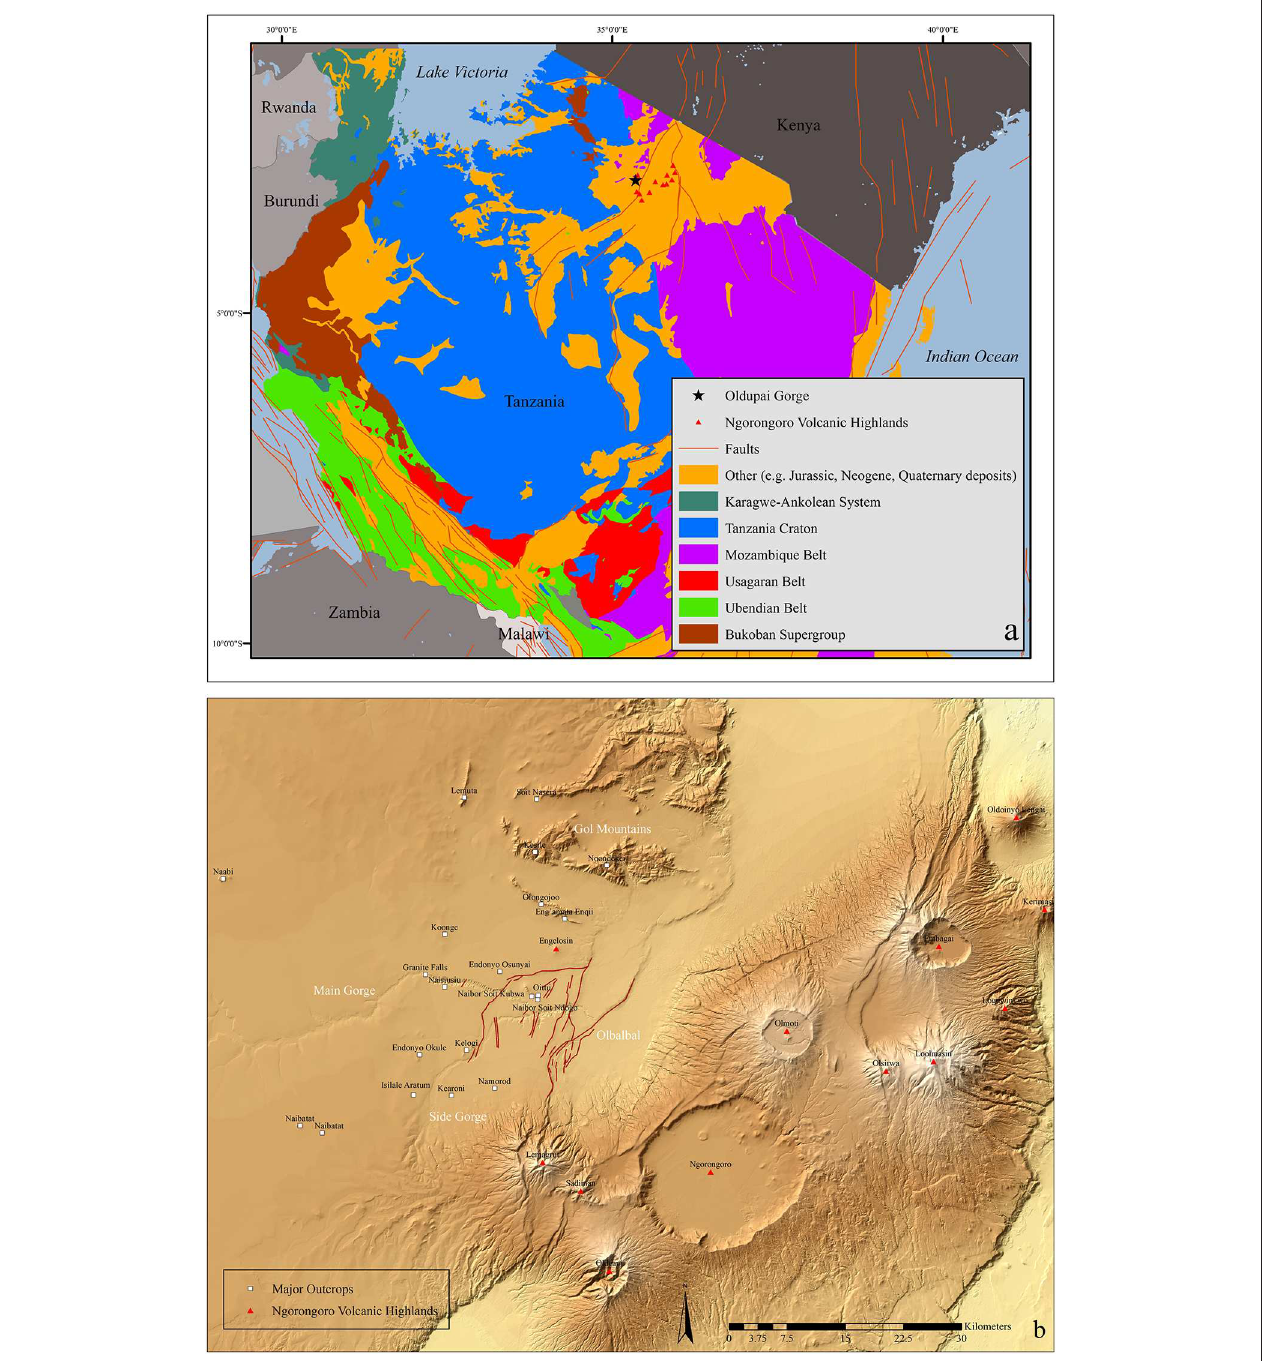
FIGURE 1 | (a) The East African Rift System superimposed over the Tanzania Craton, the Mozambique Belt, and other units. Geospatial data from Fritz et al. (2013) and Macgregor (2015). Refer to Kabete et al. (2012, Figure 5) for a detailed geological map of Tanzania. Refer to Scoon (2018, Figure 2.2) for a simplified stratigraphic column of East Africa. (b) Major geological outcrops in the greater Oldupai Gorge region. Faults after Hay